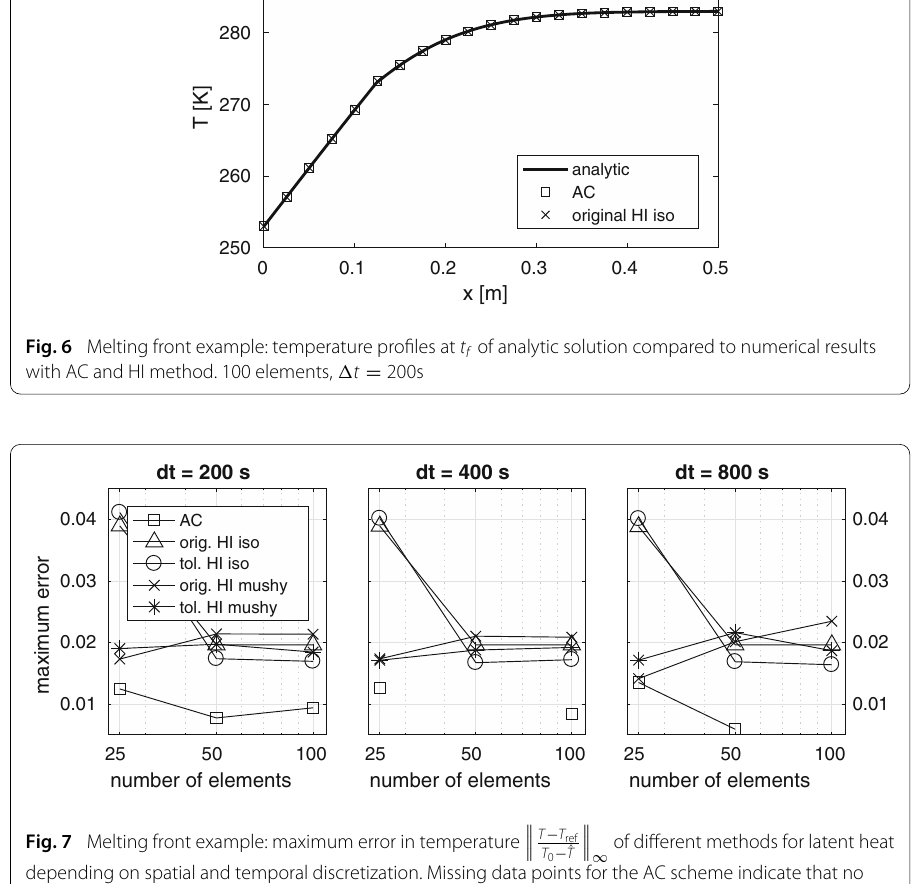
(cid:24) (cid:24) (cid:24) (cid:24) (cid:24) T − T ref (cid:24) of different methods for latent heat T 0 − ˆ T ∞